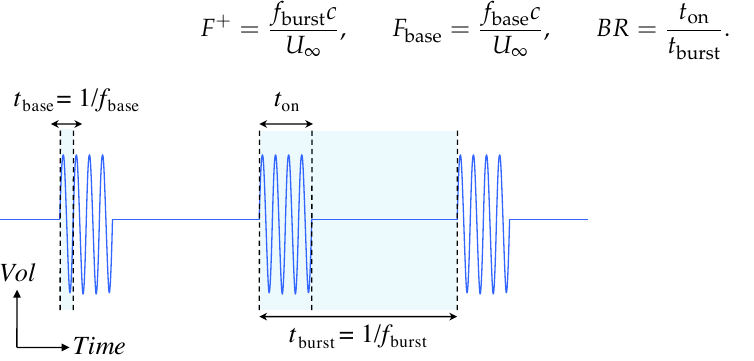
Figure 2. Waveform for burst